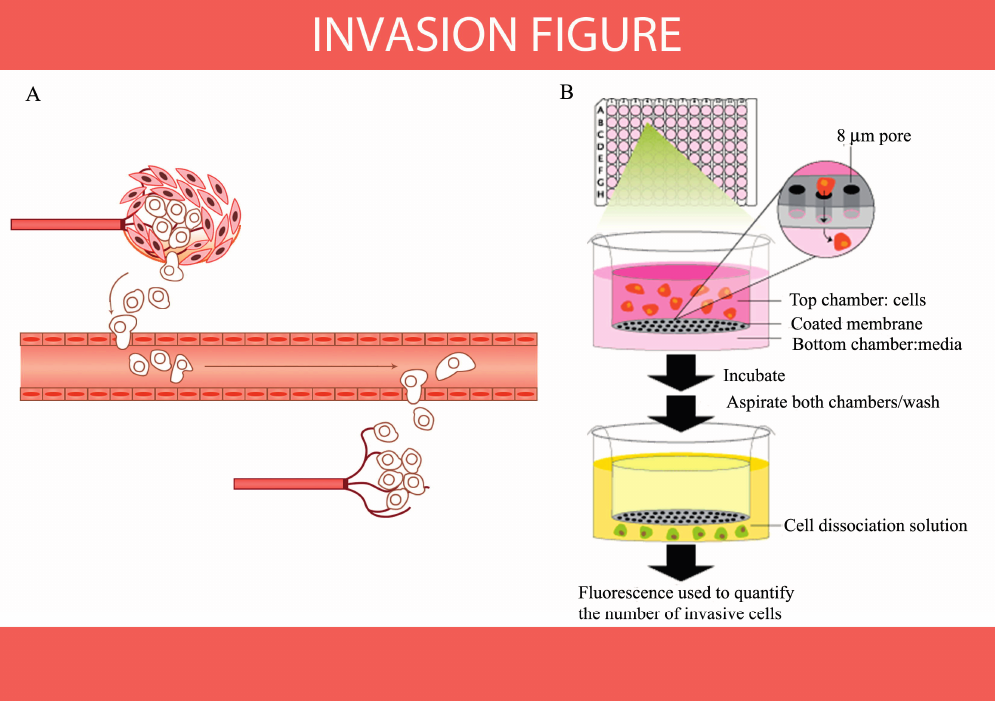
Figure 6. Aggressive malignant cancer cells are able to invade other tissues or organs with microvessels and can also induce angiogenesis. The progression from primary to metastatic tumor is a multigenic, multistep process that involves cell-cell and cell-extracellular matrix adhesion, tissue invasion and/or migration and angiogenesis. ( A ) Diagram of metastatic cancer invasion (adapted from [100] with permission from Nature Publishing Group, copyright 2005); ( B ) diagram of the in vitro invasion